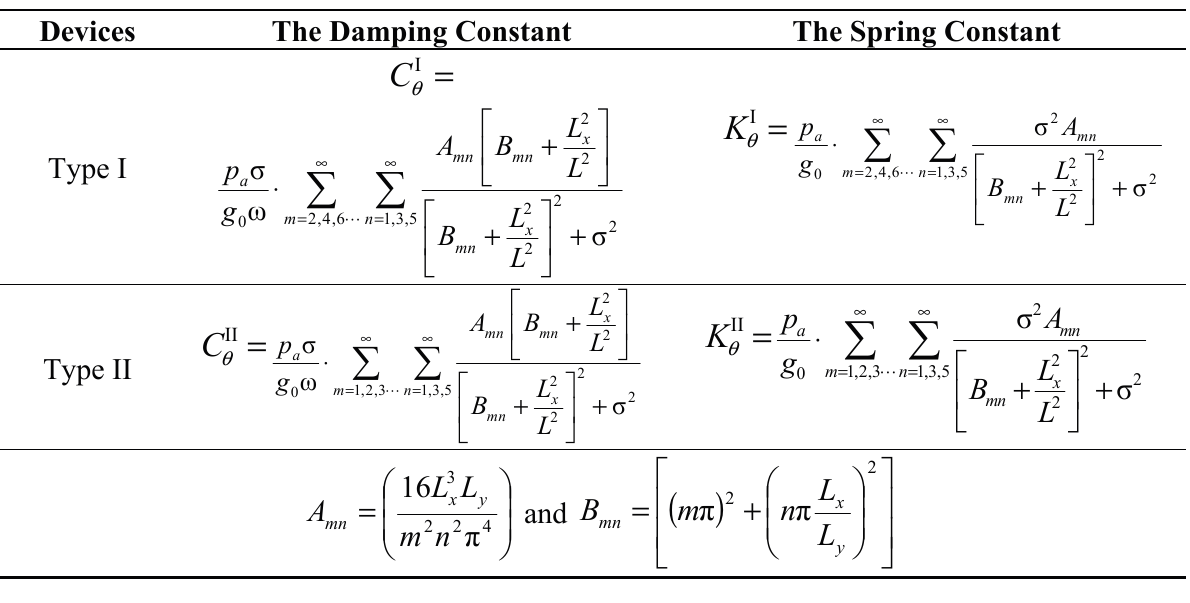
Table 2. The squeeze-film damping models for the type I and II